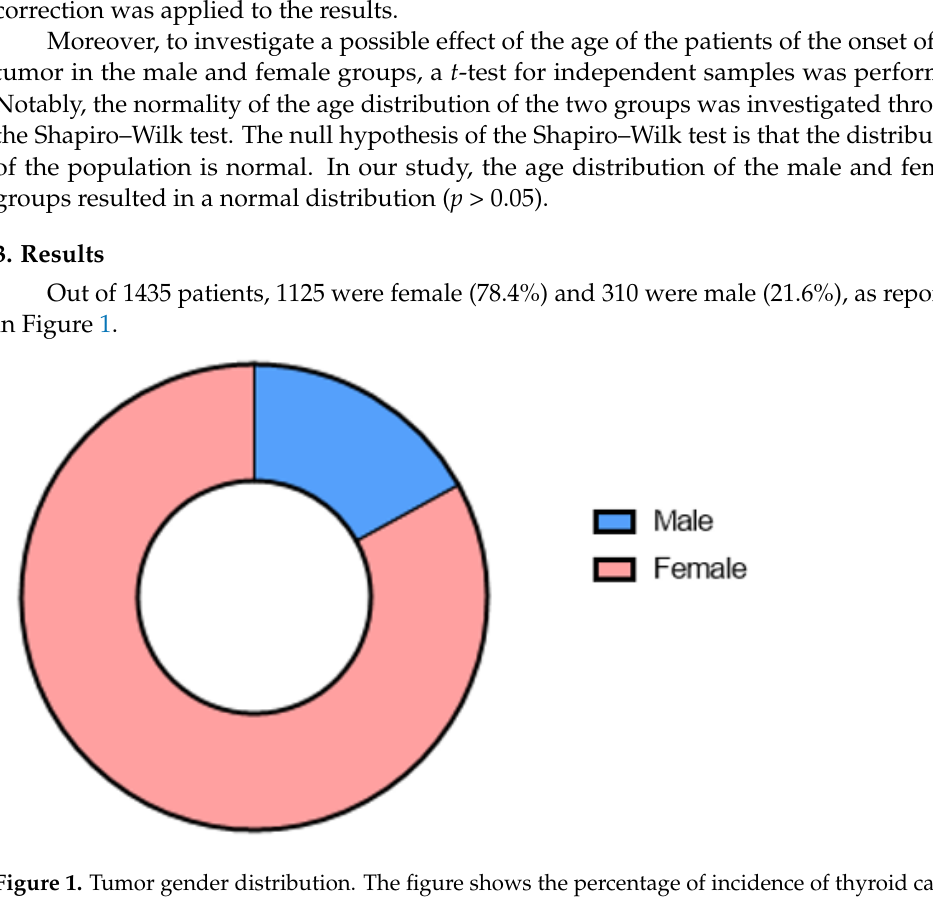
Figure 1. Tumor gender distribution. The figure shows the percentage of incidence of thyroid cancer in male (blue) and female (pink).